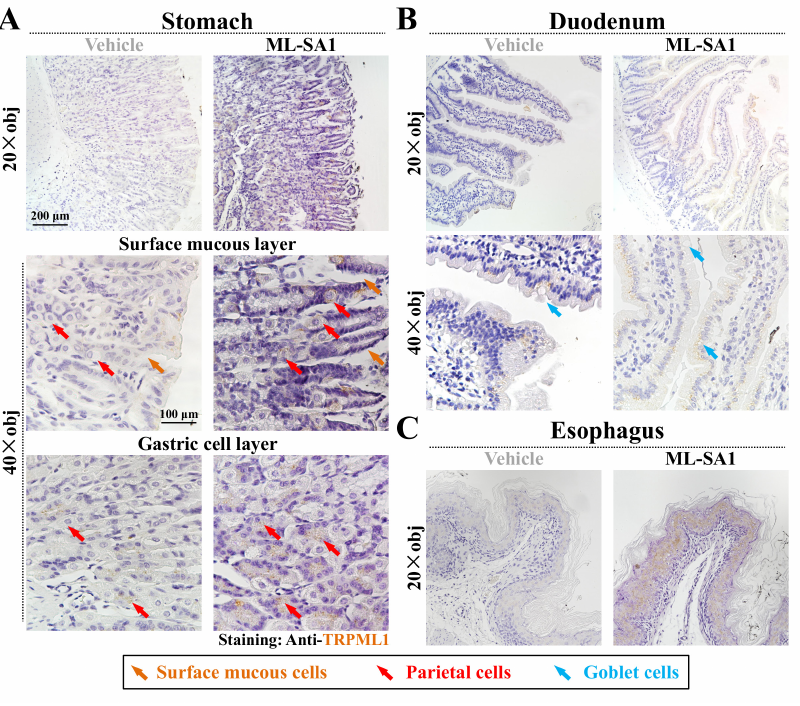
Figure 4. ML-SA1 treatment induced the expression of TRPML1 in vivo. (A) Immuno-histochemical staining of stomach sections from the vehicle-treated or ML-SA1-treated mice. Orange arrow, surface mucous cells lining the up-edge of the pits; Red arrow, parietal cells lining the medium parts of the pits. Scale bar, 200 μm for the 20× objective lens and 100 μm for the 40× objective lens. (B) Immuno- histochemical staining of duodenum sections from the vehicle-treated or ML-SA1-treated mice. Blue arrow, goblet cells. Scale bar, the same as (A). (C) Immuno-histochemical staining of esophagus sections from the vehicle-treated or ML-SA1-treated mice. Scale bar, 200 μm for the 20× objective